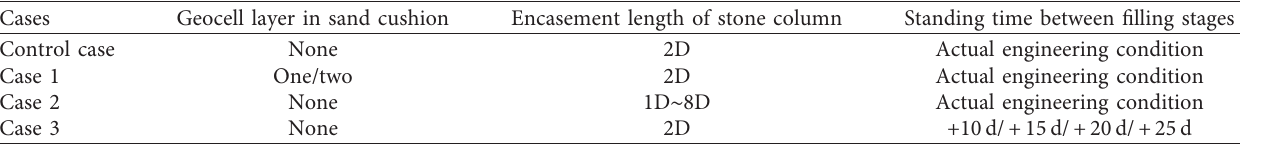
Table 2: Designed cases in the finite-element simulations.